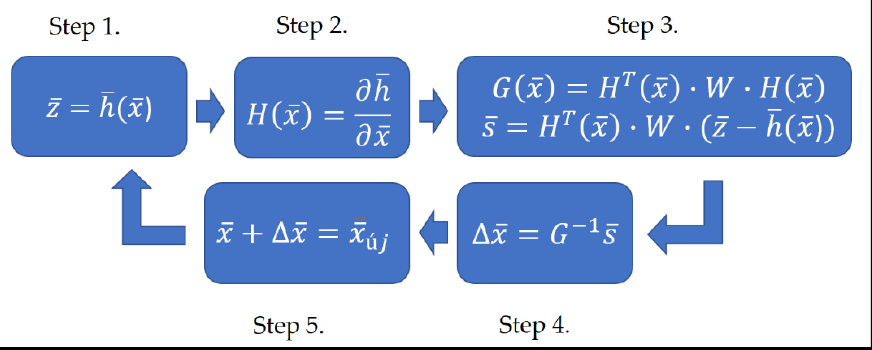
Figure 1 . Flowchart of the Gauss–Newton algorithm. Figure 1. Flowchart of the Gauss–Newton algorithm.